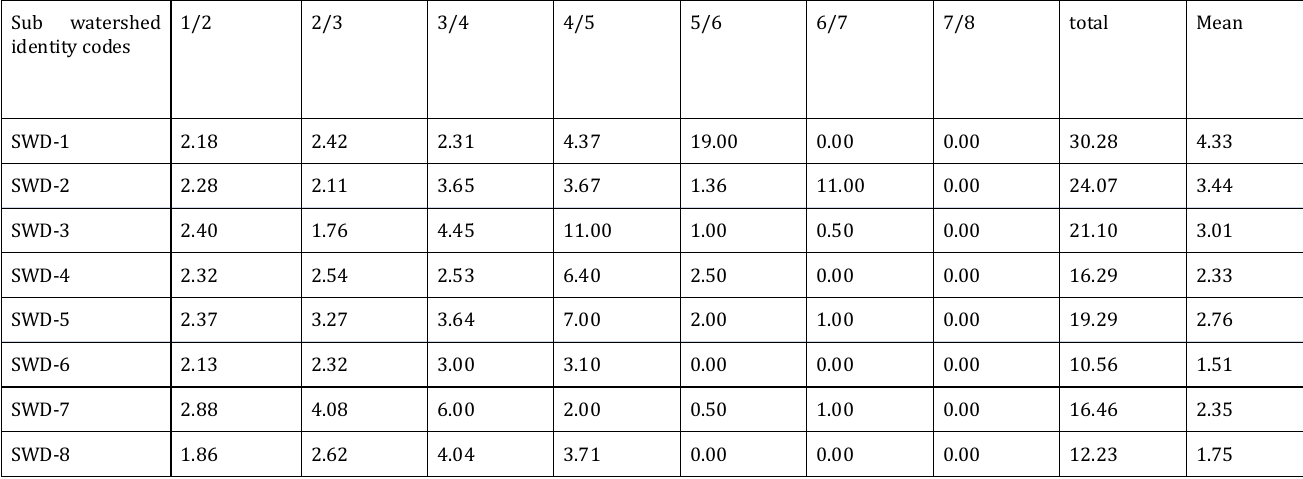
Table 9: Bifurcation ratio of upper watershed of river